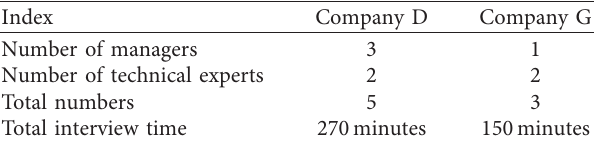
Table 2: The numbers of managers and technical experts and interview